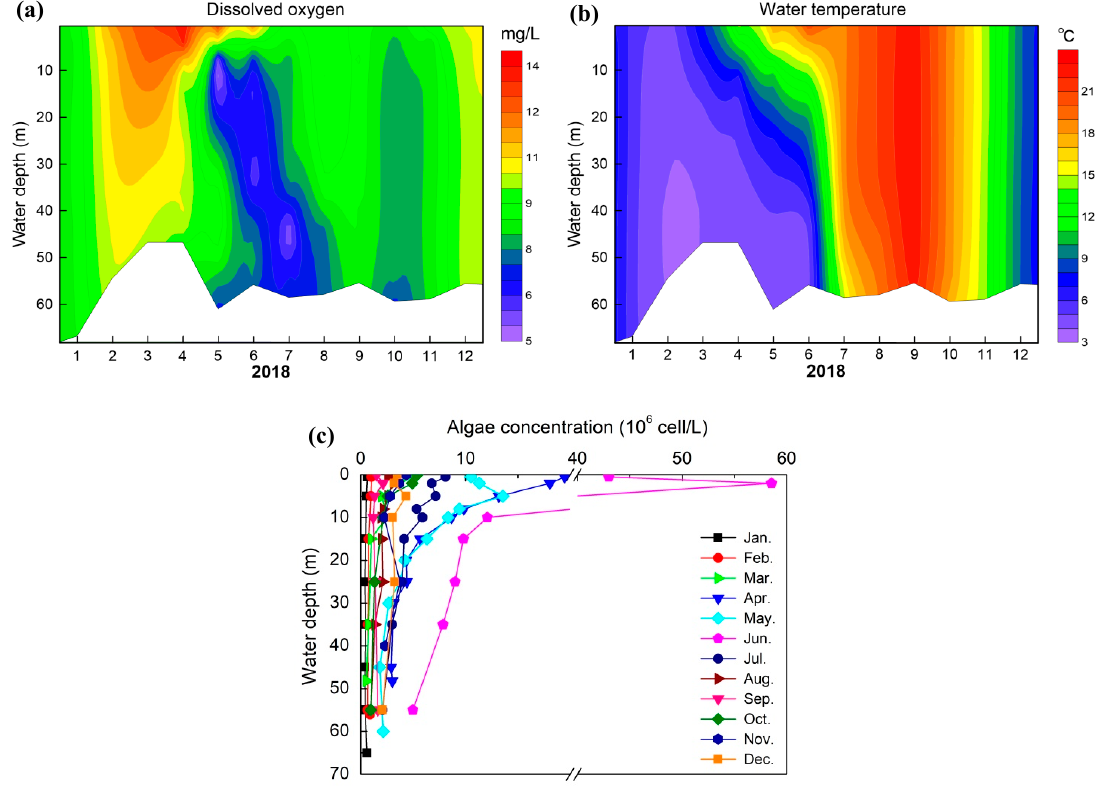
Figure 9. Seasonal DO ( a ), water temperature ( b ), algae concentration ( c ) depth profile of S1 site in Lijiahe Reservoir in 2018.